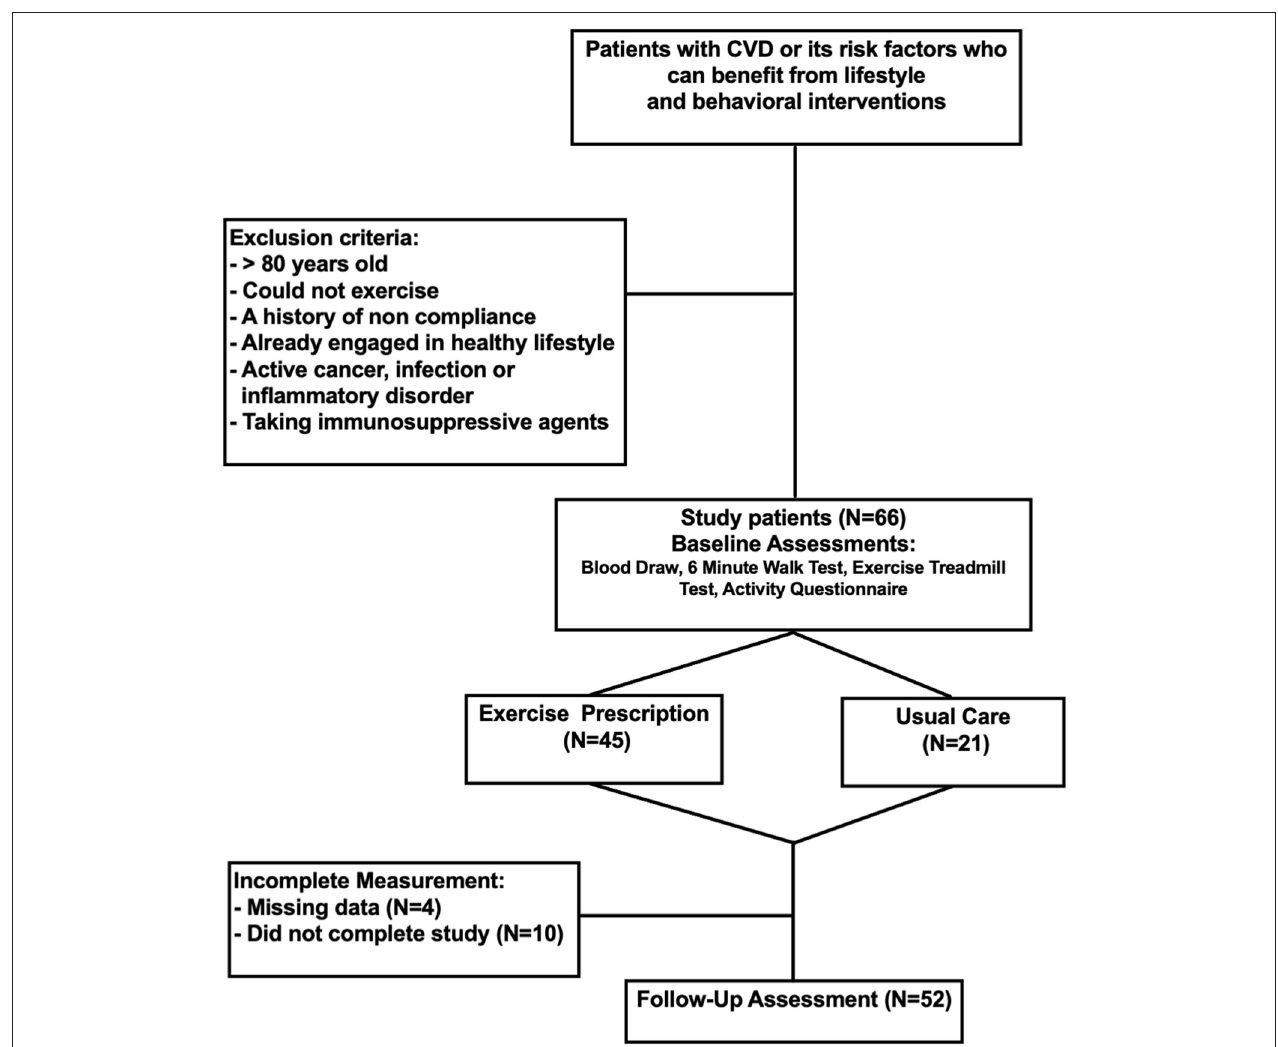
FIGURE 1 | Schematic of study